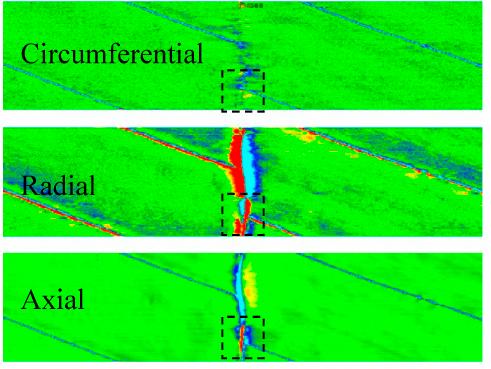
Figure 10. Three-axis magnetic flux leakage (MFL) signals of a girth weld defect.